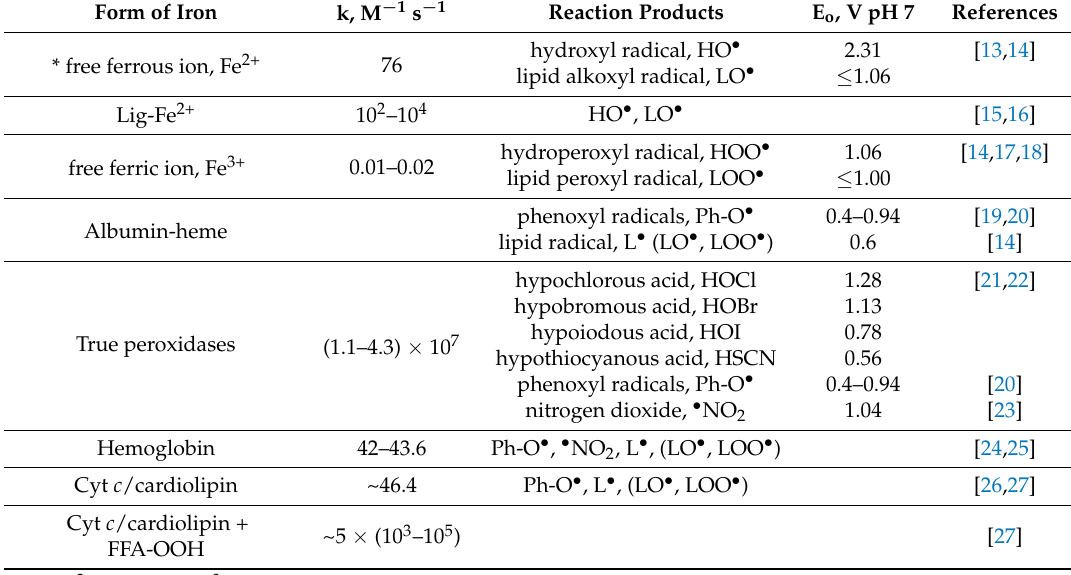
Table 1. Second order rate constants and oxidants produced in the reaction of different forms of iron with H 2 O 2 . Standard reduction potentials ( E o ) are presented for oxidative couples: HOX/X-;